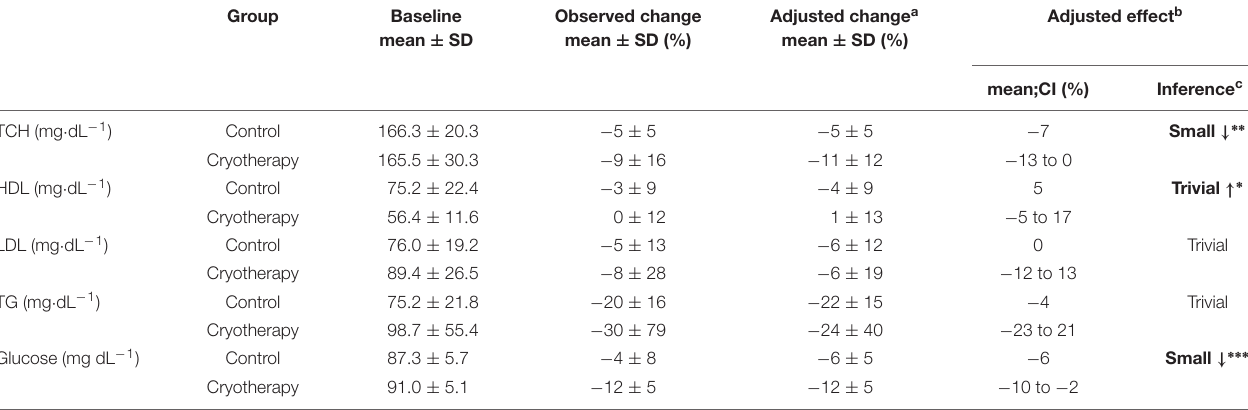
TABLE 6 | Changes in glucose and lipid profile in response to 2 weeks of specific volleyball training supported by different recovery procedures.